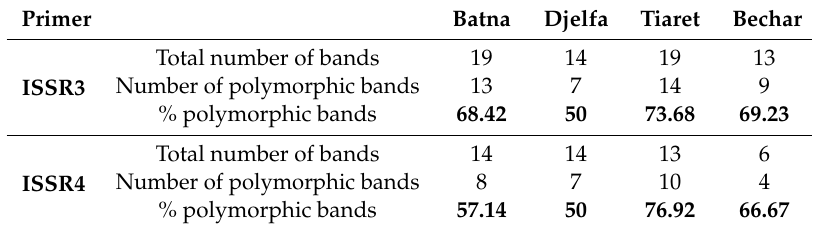
Table 1. The number of amplified and polymorphic bands observed at the di ff erent locations. ISSR, inter-simple sequence repeats. Primer Batna Djelfa Tiaret ISSR3